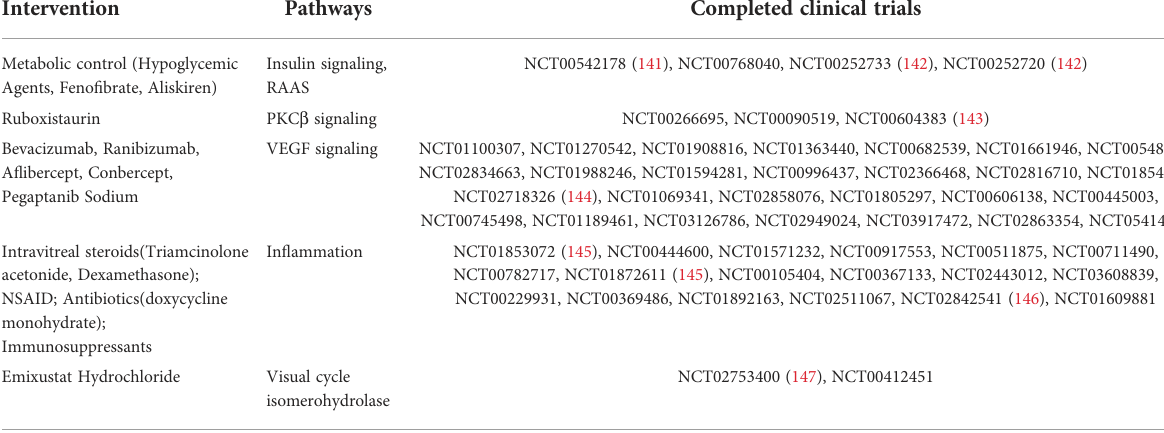
TABLE 1 Completed clinical trials of drug treatments in patients with diabetic retinopathy. Intervention Pathways Completed clinical